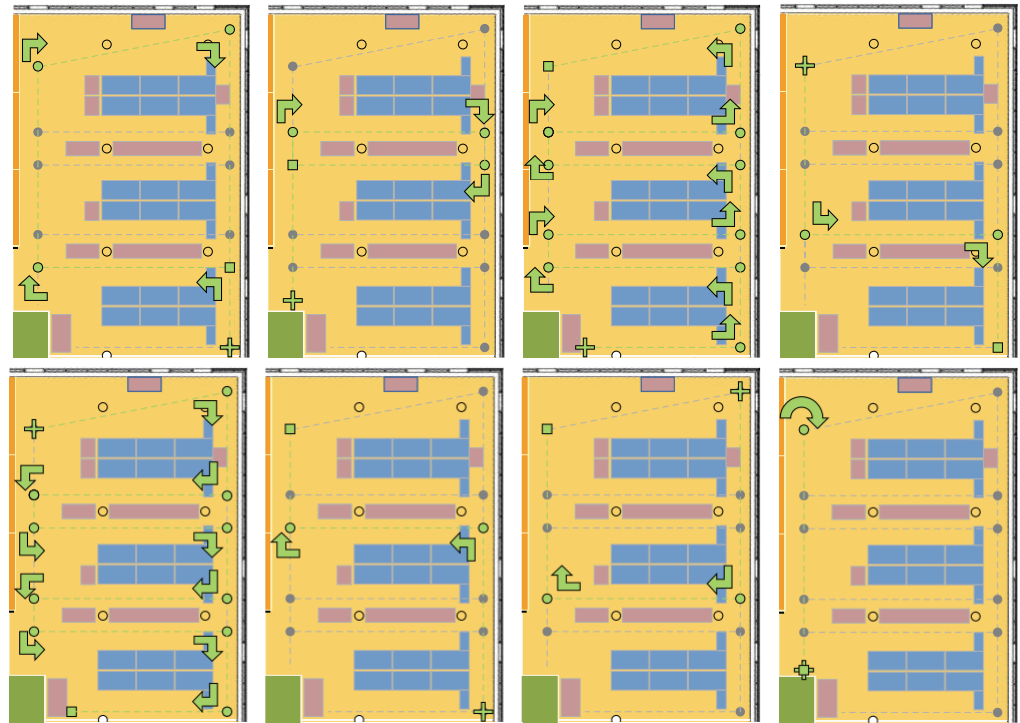
Figure 16. Various paths and trajectories adopted for the data collection in